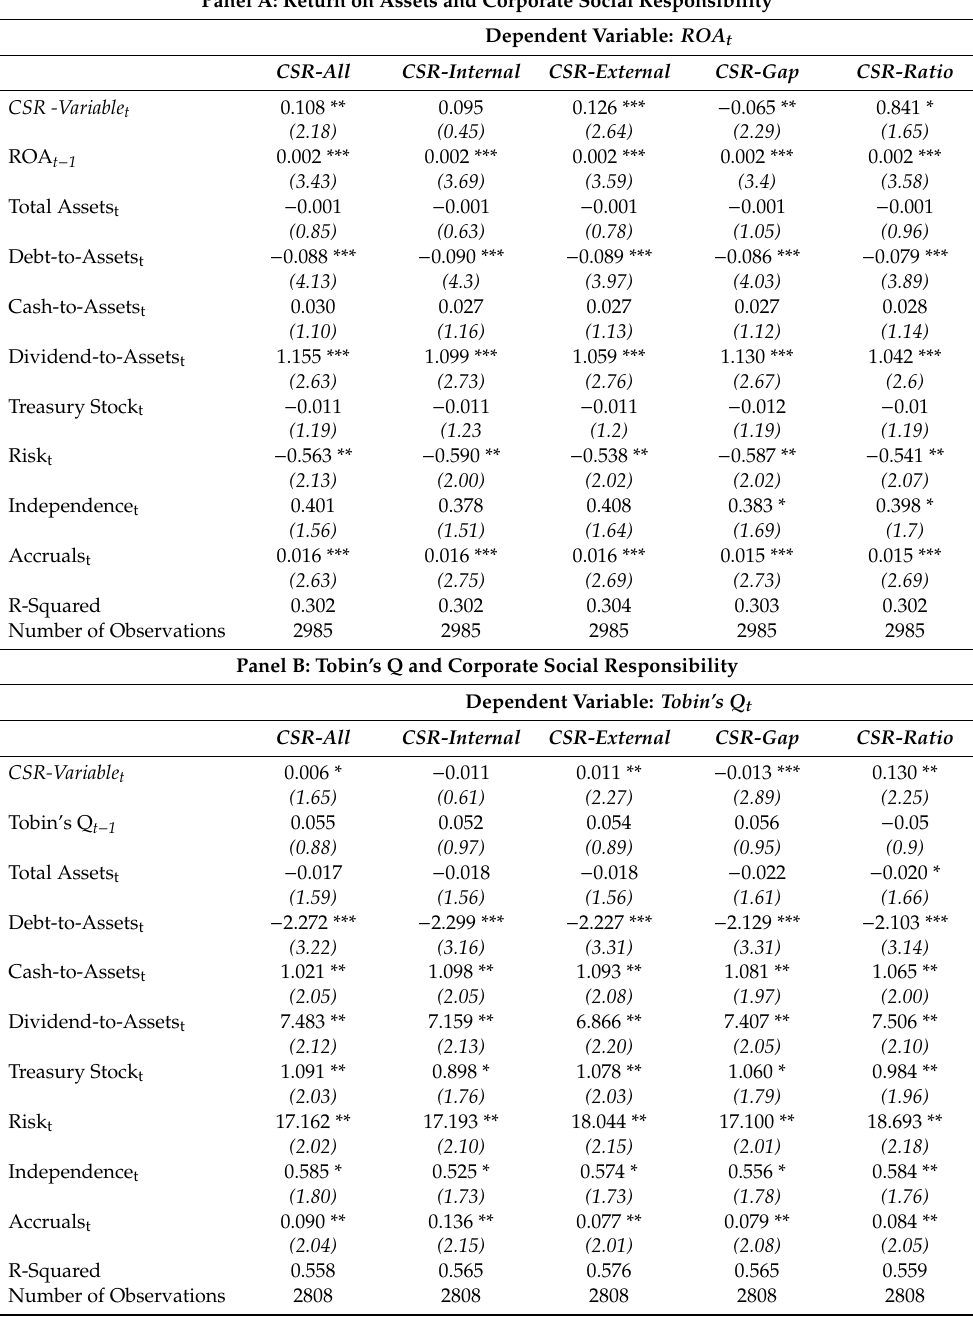
Table 3. Bank Performance and Corporate Social Responsibility. This table presents the Ordinary Least Squares (OLS) results from estimating Equation (1), or the impact that Corporate Social Responsibility has on bank performance. In Panel A, bank performance is measured by Return on Assets, or ROA. In Panel B, bank performance is measured by Tobin’s Q. In the first model, CSR-All is the CSR variable; in the second model, CSR-Internal is the CSR variable; in the third model, CSR-External is the CSR variable; in the fourth model, CSR-Gap is the CSR variable; and, in the fifth model, CSR-Ratio is the CSR variable. These variables and all control variables are defined in Appendix A. Standard errors are clustered at the firm level. Intercepts and firm and year fixed e ff ects are included in the model but not tabulated. Coe ffi cients are presented with t-statistics below in parentheses. Statistical significance is indicated with *** for 1%, ** for 5% and * for